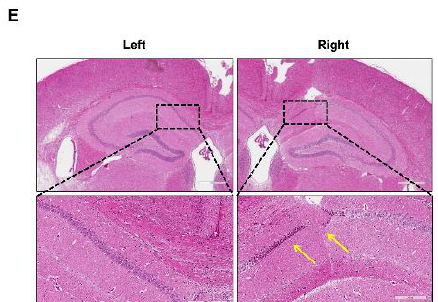
Figure 5. Pathological features of 5XVCI mice. ( A ) Locations of the infarcts were corroborated by matching MR images with the respective histological stains. Compared to WT VCI mice, infarcts appeared in similar locations. L indicates left and R indicates the right hemisphere of the mouse brain. (1) forceps minor (2) external capsule of the corpus callosum (3) caudate putamen (4) hippocampal fimbria. ( B ) Total number of infarcts observed from 2 of the 5 5XVCI mice (5XVCI 5, 6). ( C ) Distribution of infarcts. CC = corpus callosum, CPu = caudate putamen, AC = anterior commissure, Hippo = hippocampus, and HF = hippocampal fimbria. ( D ) Volume of the cerebral infarcts (mm 3 ). ( E ) Hippocampal neuronal death (left solid yellow arrow) and structural alterations (right solid yellow arrow) in the hippocampus were observed in the unilateral hippocampus of 5XVCI mice. Scale bar = ( A ) 2 mm, ( E ) From top to bottom: 400, 200 µ m.